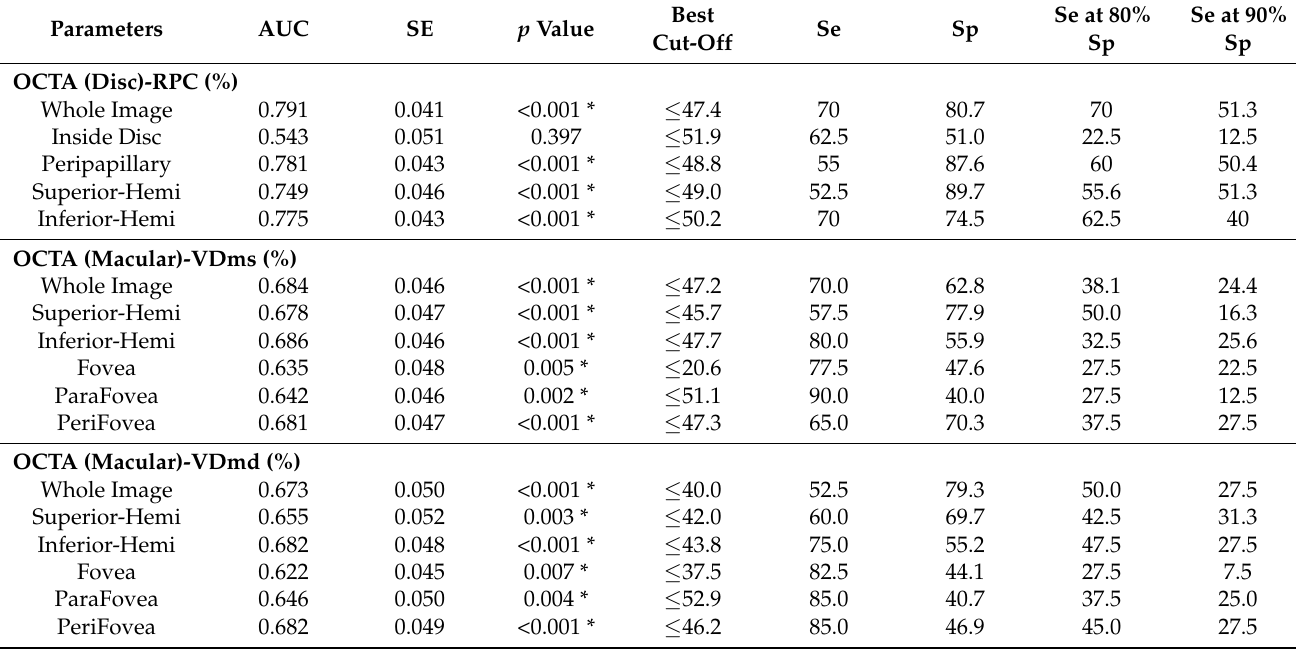
Table 4 revealed that the most sensitive parameters for discerning the control group